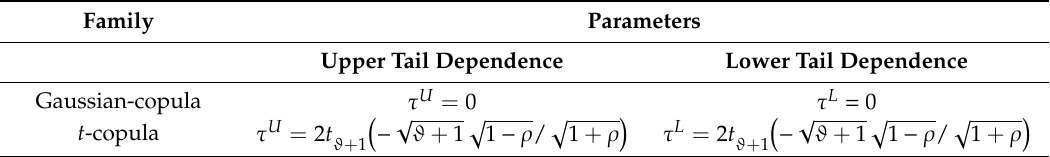
Table A1. Description parameters of